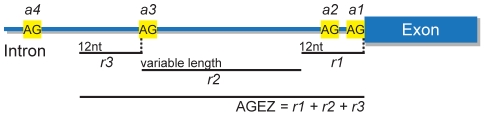
AGEZ definition and BP search region.BP location relative to the 3SS (a1) is dependent on presence/absence additional AG dinucleotides in the intron. The most common situation is the absence of AGs in the region between the BP and the 3SS. However, these can occur either at locations close to the 3SS (i.e. a2 in r1) where they may compete with the 3SS signal, or very close to the BP (i.e a3 in r3), where they are bypassed possibly due to steric constraints. Any AG occurring in r2 is likely to be recognized as 3SS. Therefore, BPs are usually located inside region defined as r1+r2+r3 – the AG exclusion zone (AGEZ).